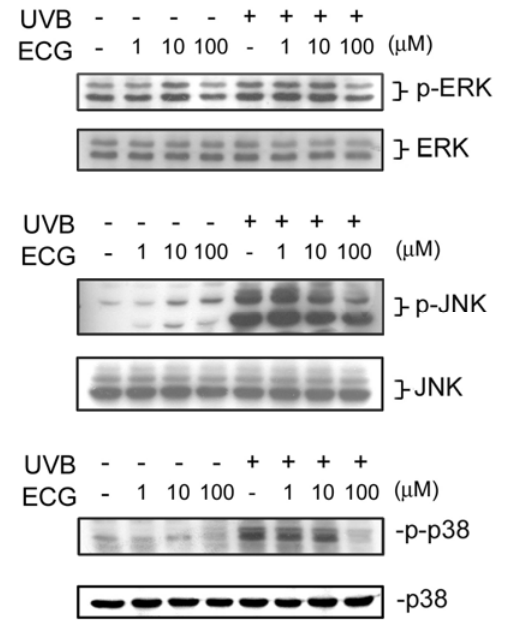
Figure 4. Effect of ECG on UVB-induced ERK1/2, JNK and p38 activation.